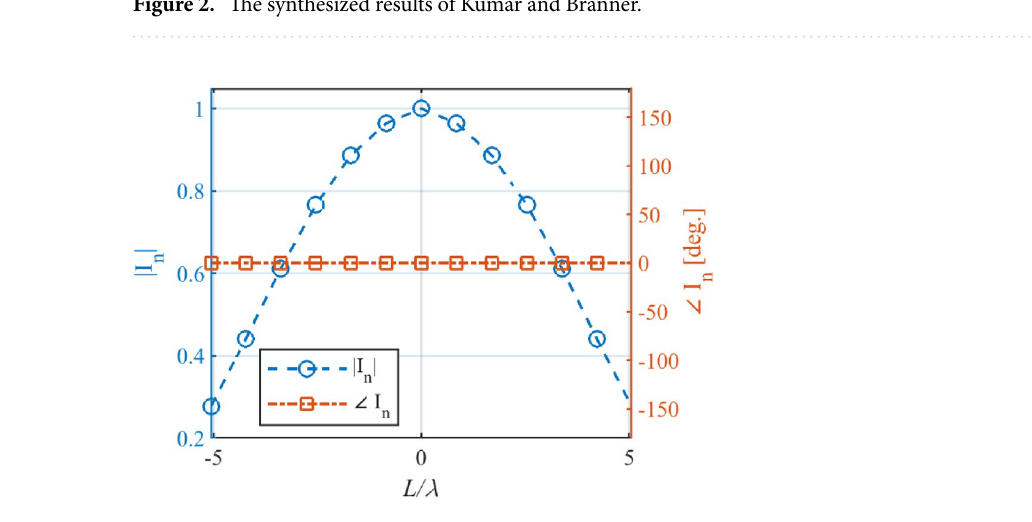
Figure 3. The calculated I n versus L /λ for Kumar and Branner pattern.